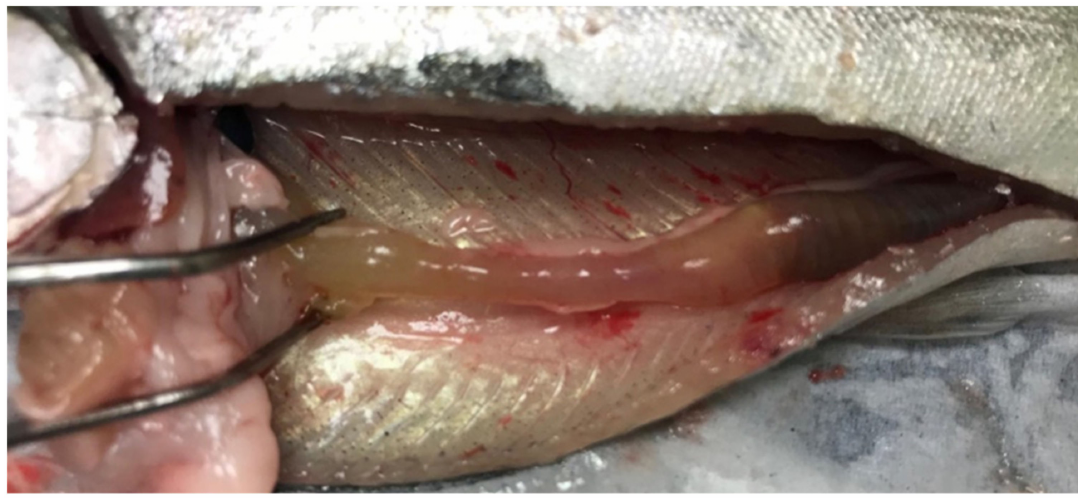
Figure 1. The digestive tract filled with yellow liquid content in the course of ERM.